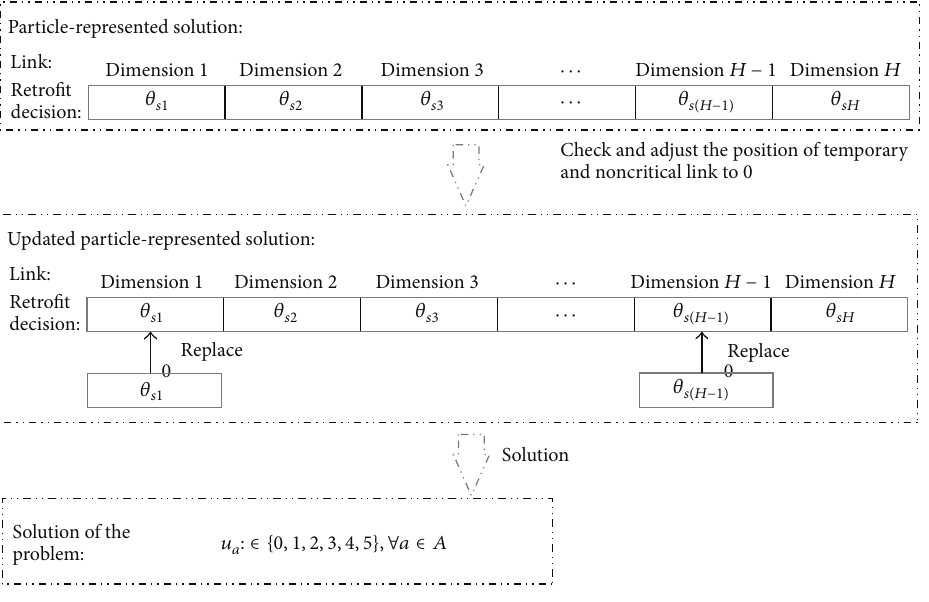
Figure 6: Transformation from the particle-represented to the problem